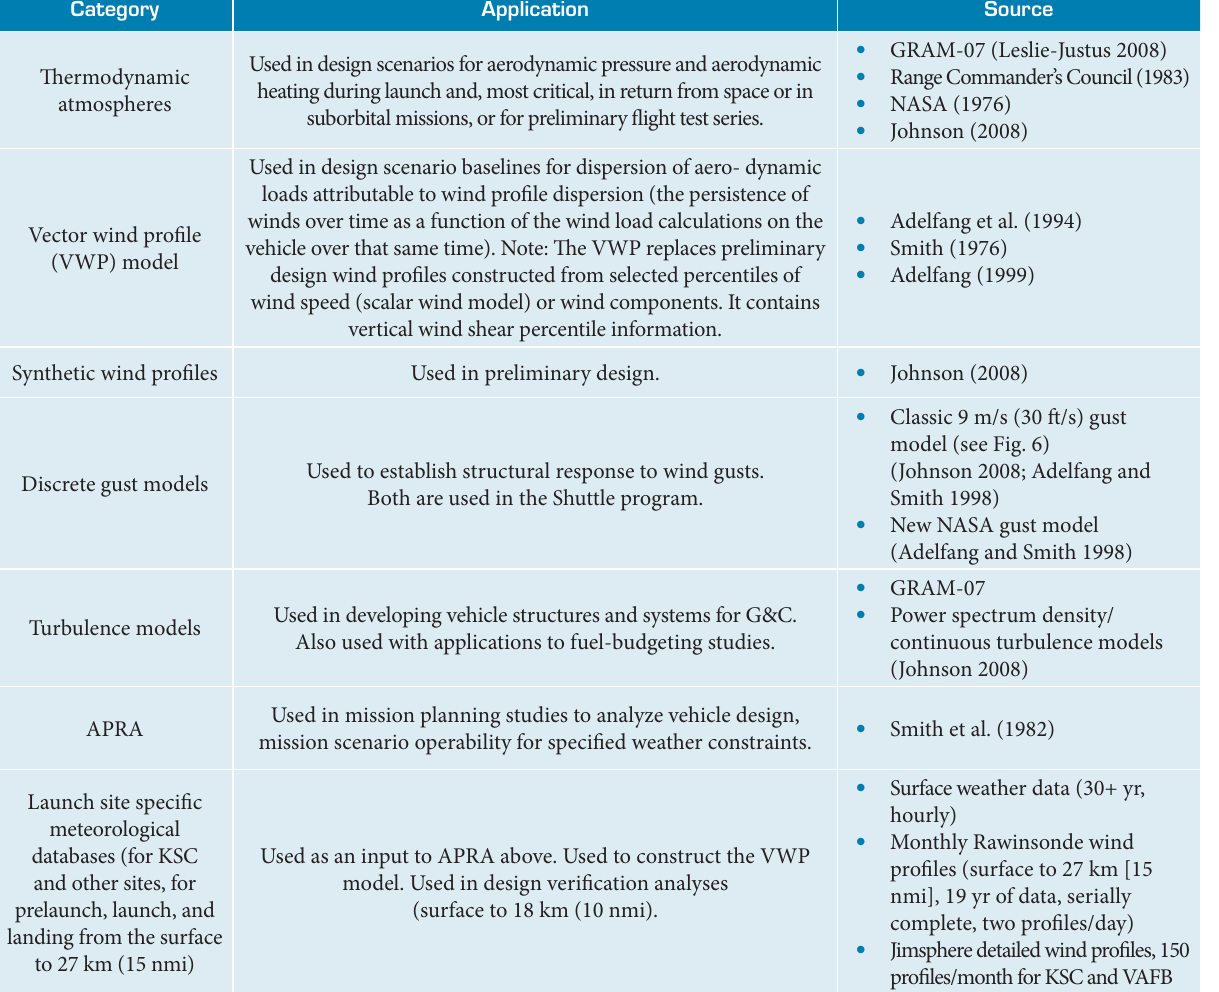
Table 1. Categories of natural terrestrial environment models and their